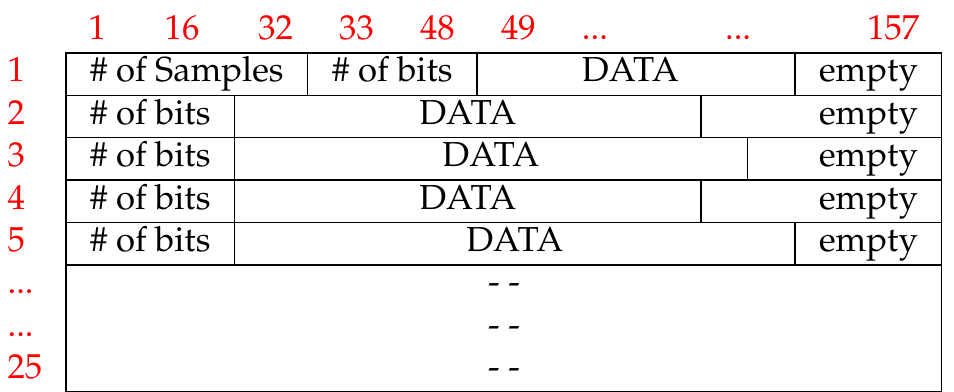
Figure 4. Encoding block